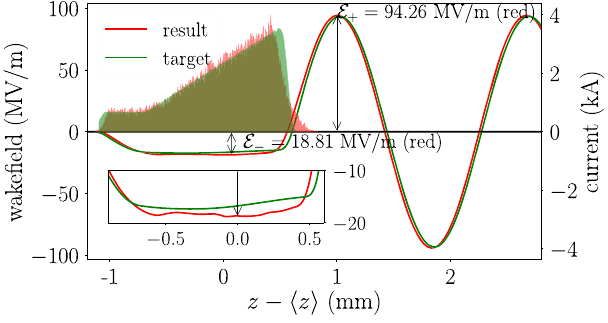
FIG. 16. Target (from Fig. 2) and optimized final current distributions (respectively shown as green- and red-shaded curves) with associated wakefields (respectively displayed as green and red traces). The transformer ratio for the simulated distribution is R ¼ 5 . 0 .